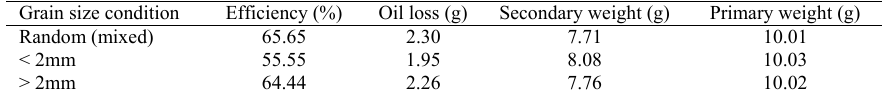
Table 2: Efficiency of grained samples in SCR of 4